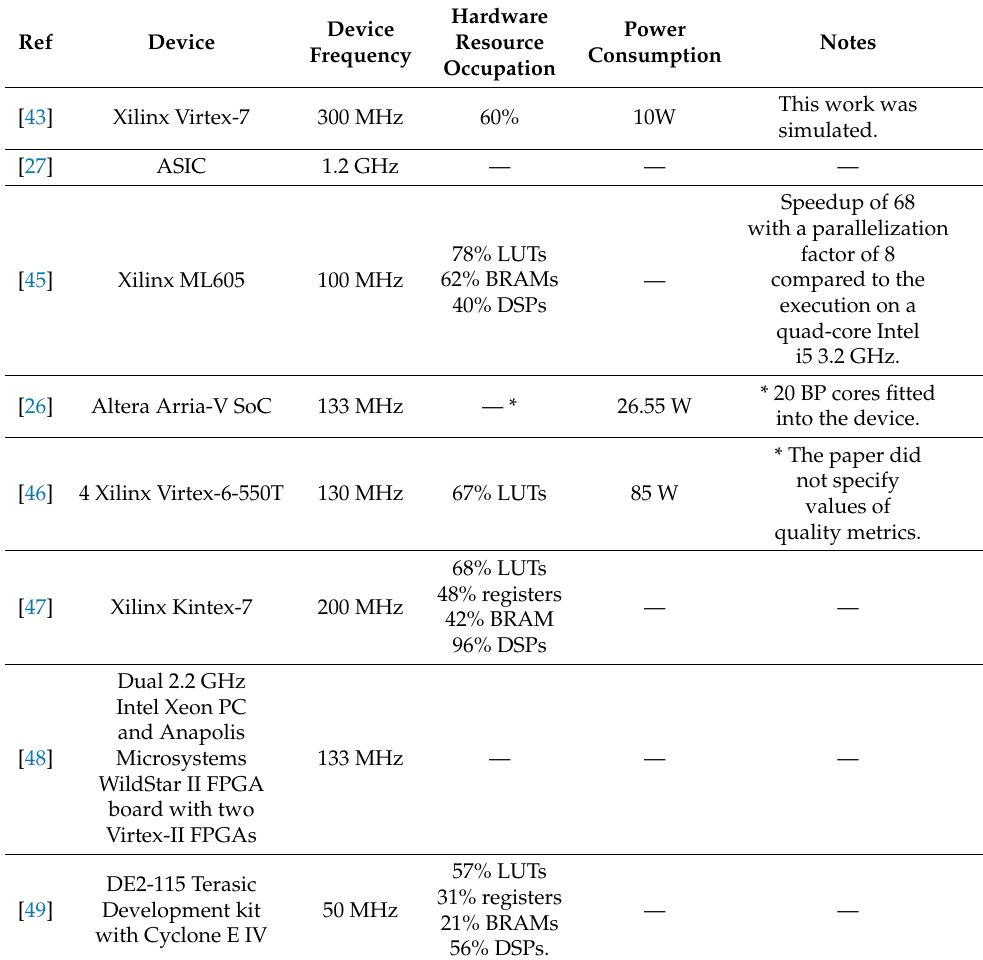
Table 9. Comparison between the different hardware implementations of SAR image formation algorithms, described in Section 4.4. This table includes the device reference, device frequency, hardware resources, power consumption and additional